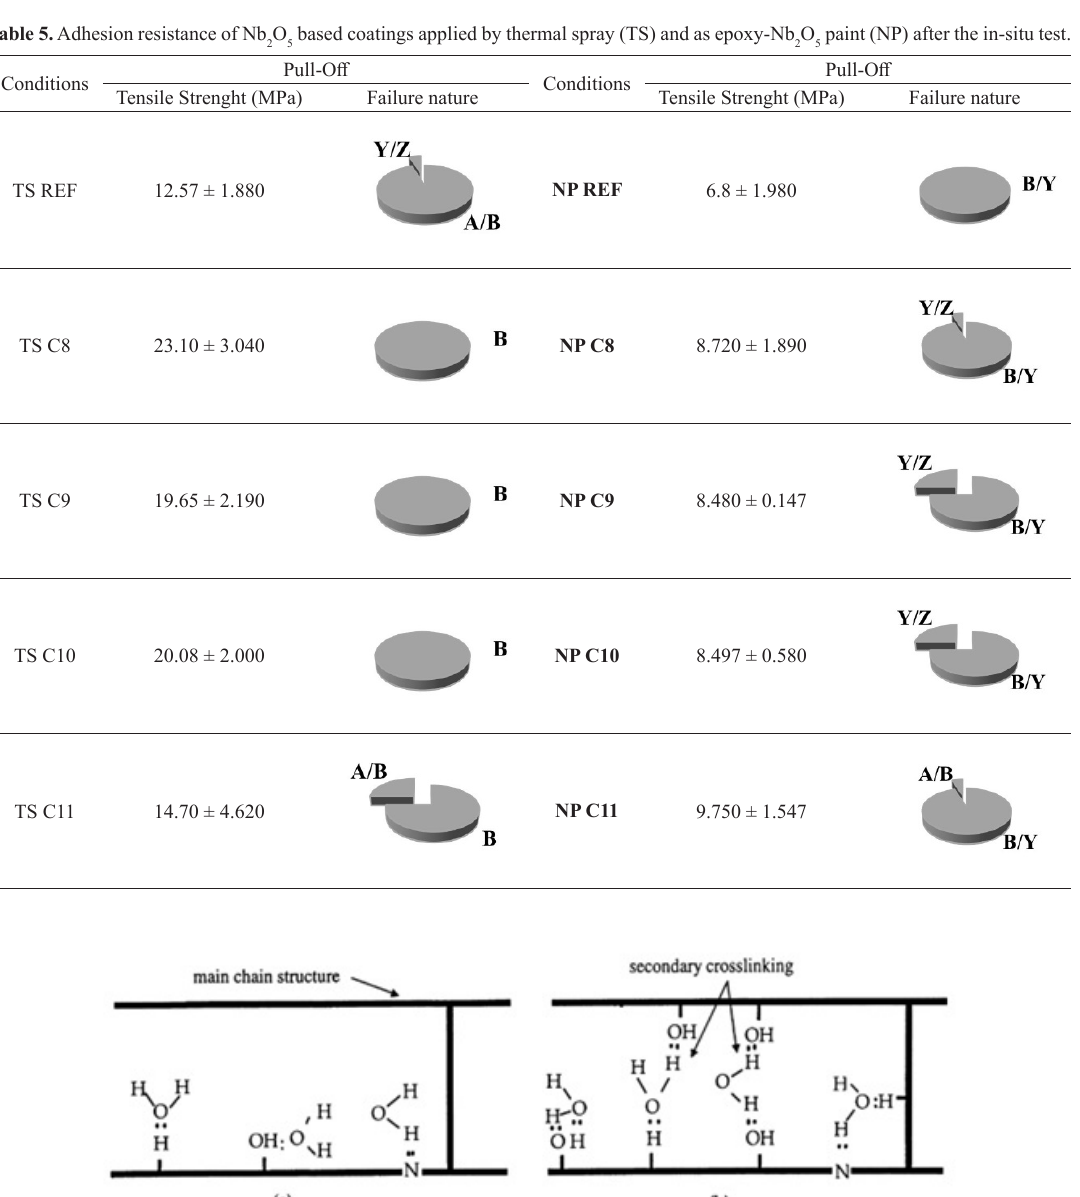
O paint (NP) after the in-situ test. 2 5